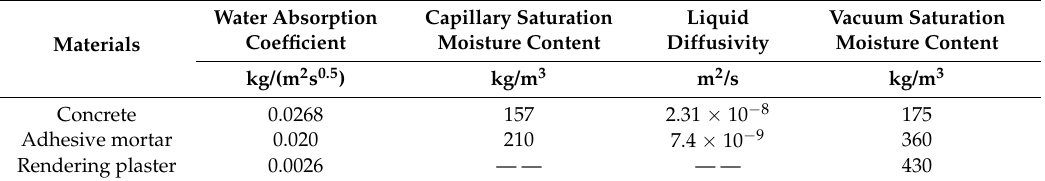
Table 3. Some hygric properties of building